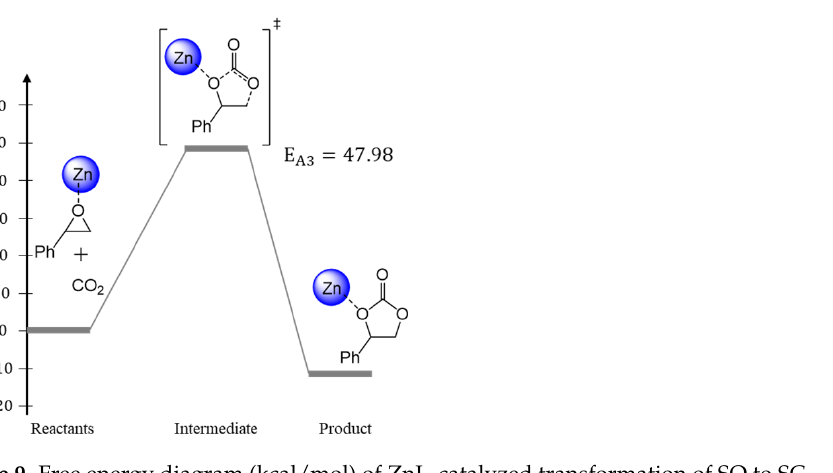
Figure 10. Proposed tetrahedral ZnI 2 (SO) 2 complex with a π - π interactions (green).